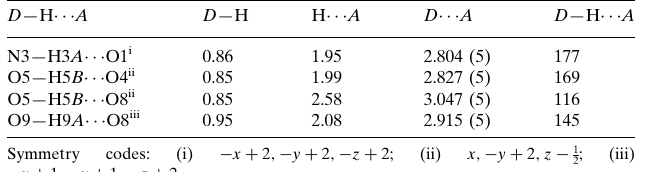
Hydrogen-bond geometry (A˚ , (cid:2) ). D —H (cid:1)(cid:1)(cid:1)